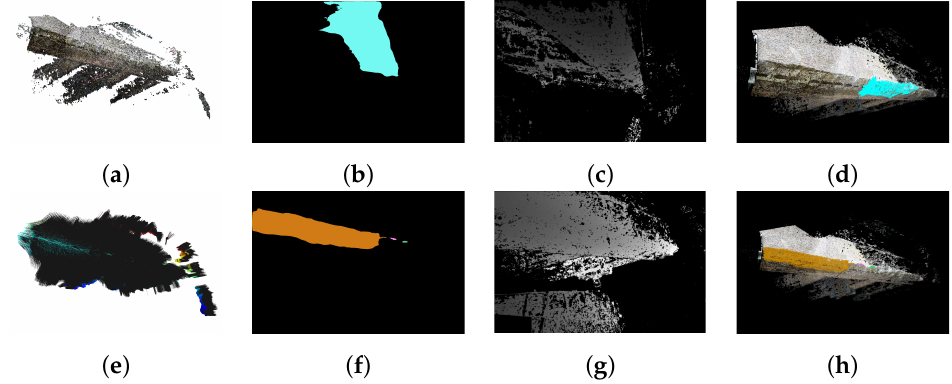
Figure 11. Inference output of the retrained TernausNet16 model via transfer learning on the use case inspection images. ( a ) First inspection image for the presented case study. ( b ) The resulting prediction map of ( a ) from inference. ( c ) Binary thresholded prediction mask of ( b ). ( d ) Binary mask overlaid onto the image in ( a ). ( e ) Second inspection image. ( f ) The prediction map of ( e ). ( g ) Binary thresholded prediction mask of ( f ). ( h ) Binary mask overlaid onto the image in ( e ).